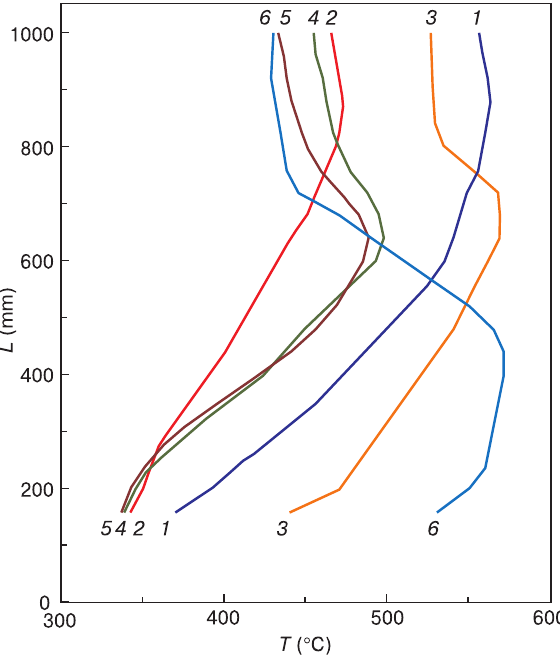
Figure 6. Axial temperature distribution in furnace unit for Te refinement stages: ( 1 ) filtration; ( 2 ) first distillation; ( 3 ) first drain; ( 4 ) degassing; ( 5 ) second distillation; ( 6 ) second drain